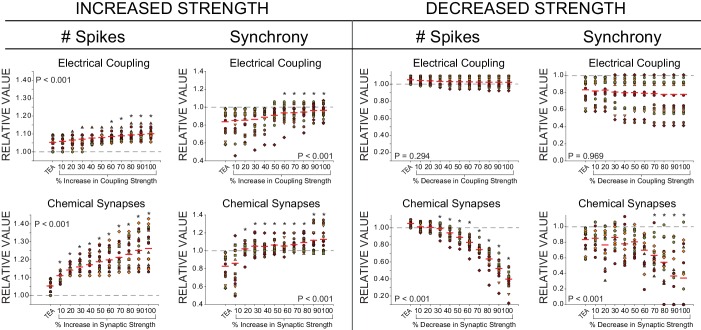
Effects of increased or decreased strength of chemical synapses and electrical coupling on excitability and synchrony in model CG networks.Measurements of two output variables (# of spikes and synchrony) were made under three model conditions: control, TEA (90% reduction in both GKd and GBKKCa), and TEA + an incremental increase or decrease (up to 100% by 10% increments) for both chemical (pacemaker to LC) or electrical (LC to LC) connections. N = 27 distinct model networks. All output measurements are normalized to their initial (control) conditions to visualize trends. Dashed line represents the 1.0 value (baseline) for a given measure. Red lines represent the mean for each group. Each different colour and shape for points corresponds to one model network, and the same networks are shown across conductance levels. P-values in each plot refer to the results of a one-way ANOVA across all groups. Asterisks (*) denote groups in each plot that were significantly different from the TEA group via Holm-Sidak post-hoc tests.